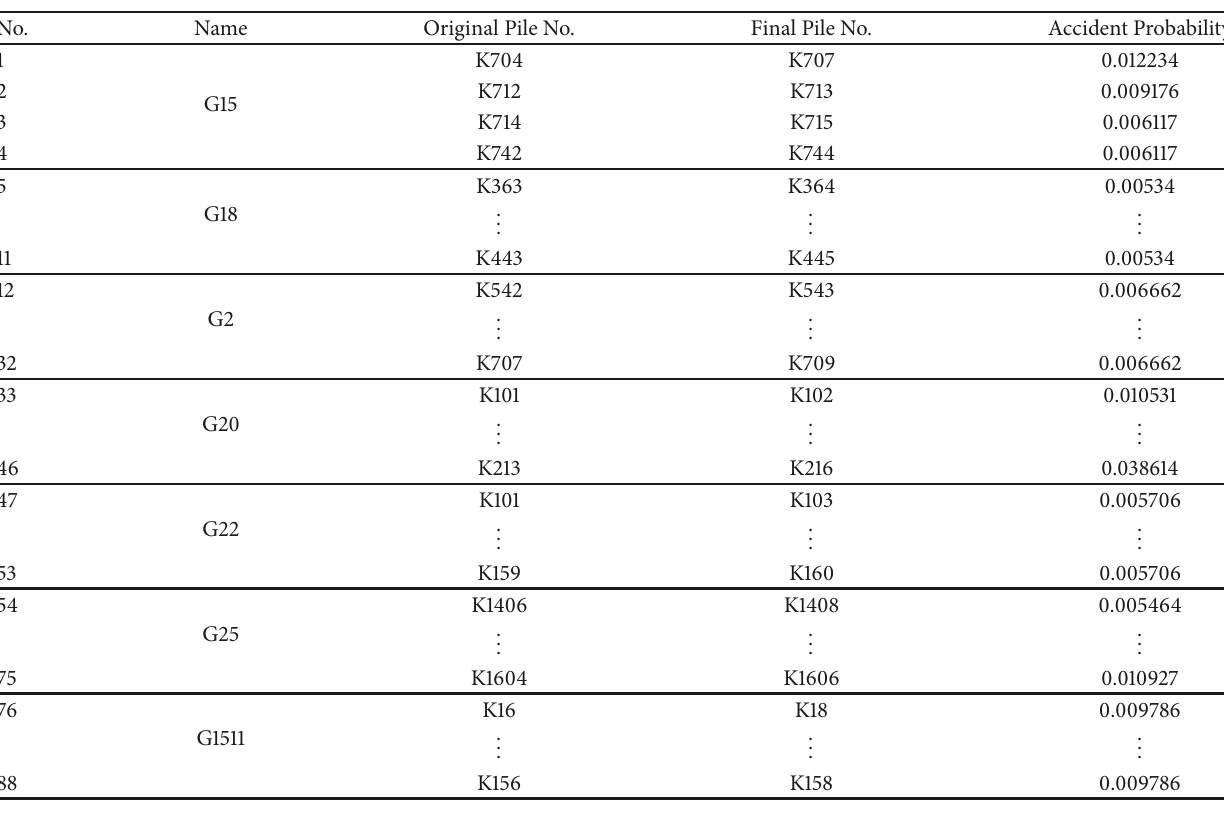
Table 5: The results of accident probability.